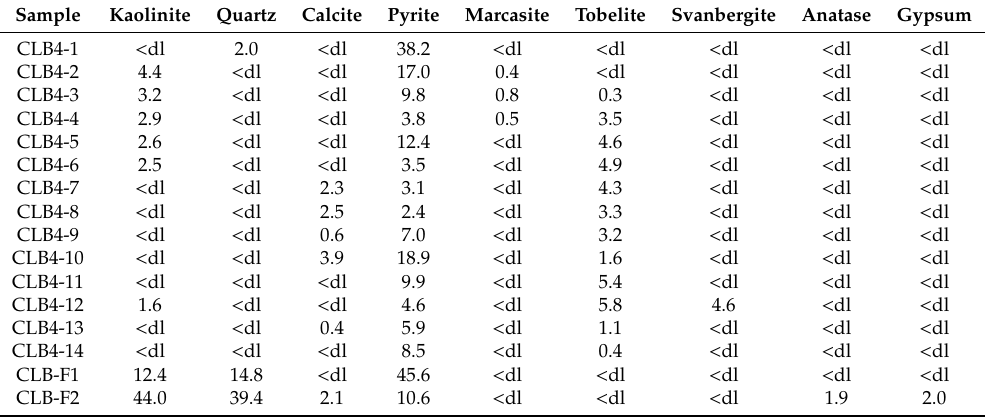
Table 2. Mineralogical proportions of the coal and floor samples determined by X-Ray Di ff raction (XRD) from the Chalinbao underground coal mine in the Tongzi Coalfield (on whole-coal basis; unit in%). Sample